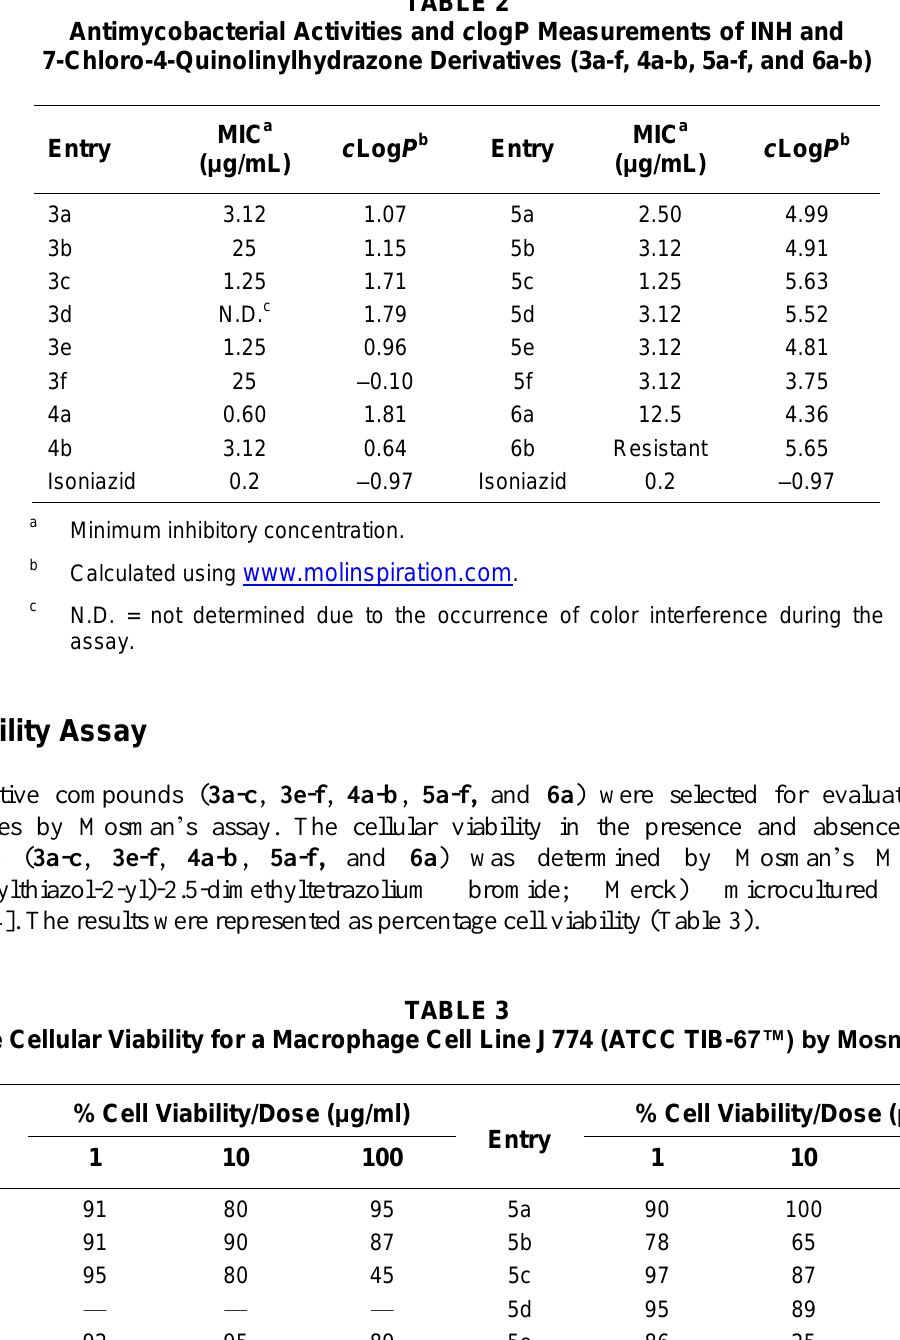
Antimycobacterial Activities and c logP Measurements of INH